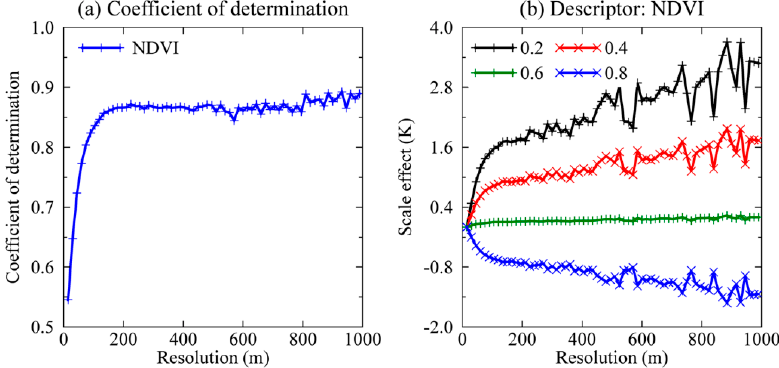
Figure 3. ( a ) R 2 in training the regression function of LST-NDVI and ( b ) the quantified scale effect at different NDVI values based on the TASI simulated LSTs.